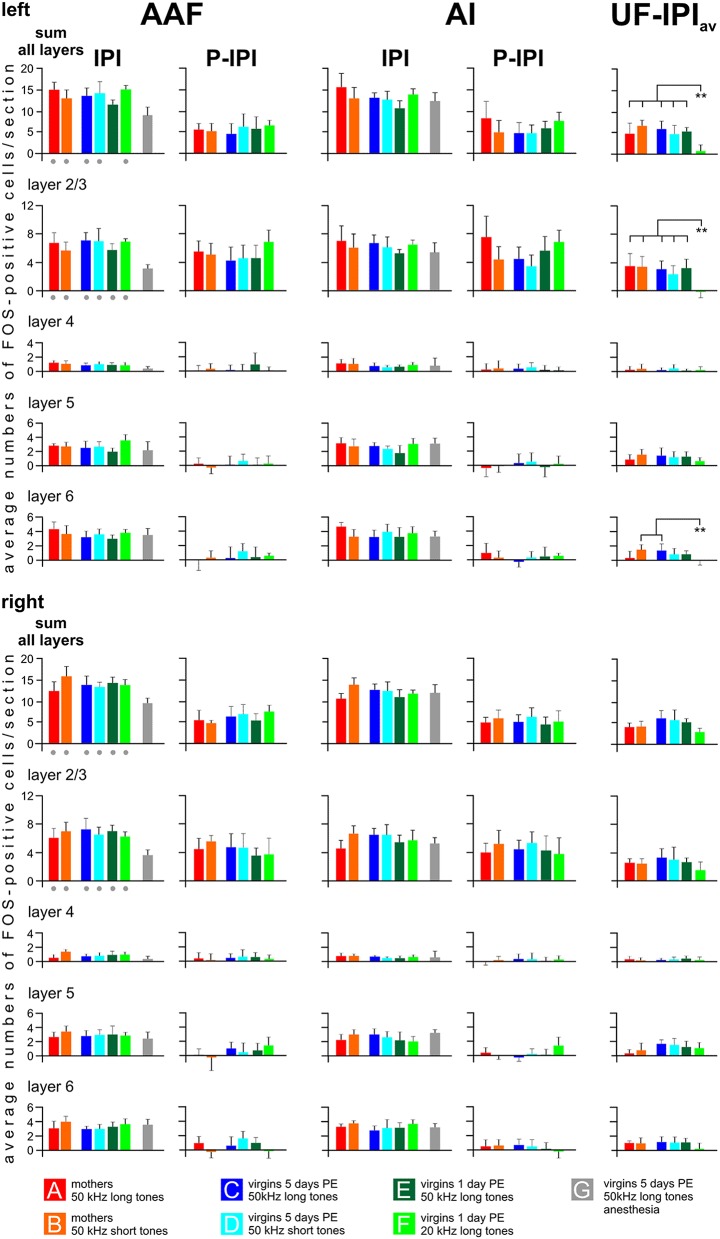
Distribution of FOS-positive cells in the primary (AI), anterior (AAF), and ultrasonic (UF) fields in cortical layers. Data for AAF and AI are shown separately for all experimental groups and both hemispheres as values (means with standard deviations) of the inter-peak intervals (IPI) and the peak after subtraction of the respective IPI value (P—IPI). The labeling peaks in AAF and AI clearly relate only to layers 2/3. The values for UF indicate the difference UF—IPIav, whereby IPIav is the average IPI value from the AI and AAF of the respective groups. Labeling above the background is found in UF in layers 2/3, 5, and 6. IPI values of anesthetized animals (group G) are significantly smaller (p < 0.01) in the sum of all layers and in layers 2/3 of AAF than the respective values of all other groups (gray dots below the colored bars). The values UF—IPIav of group F virgins are significantly smaller (p < 0.01) than the values of the indicated other groups. The anesthetized animals of group G did not show labeling peaks in AAF and AI and, in UF, no labeling above the background. Therefore, there are no gray group G bars in the P—IPI and the UF—IPIav columns. p < 0.01 (**).